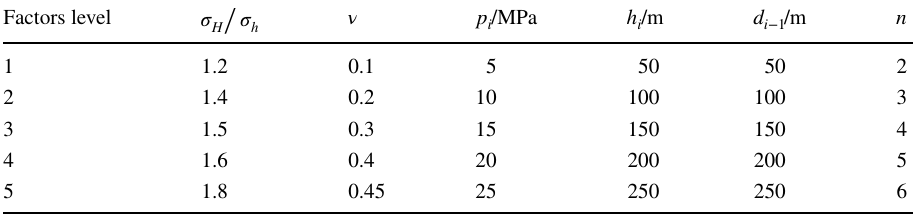
Factors level 𝜎